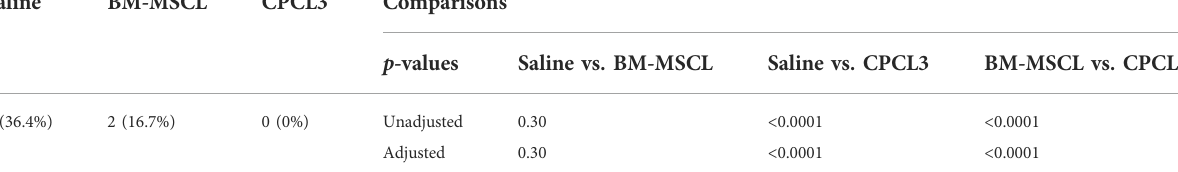
TABLE 2Prevalence ofbroken medialmenisci bytreatmentcondition.The prevalence ofbrokenmedialmeniscidifferedby treatmentcondition. The saline control group experienced signi fi cantly more broken defects than the CPCL3-treated group (36.4% vs 0%, p < 0.0001). There were no statistically signi fi cant differences in the prevalence of broken menisci in the saline control compared to BM-MSCL group ( p = 0.30).